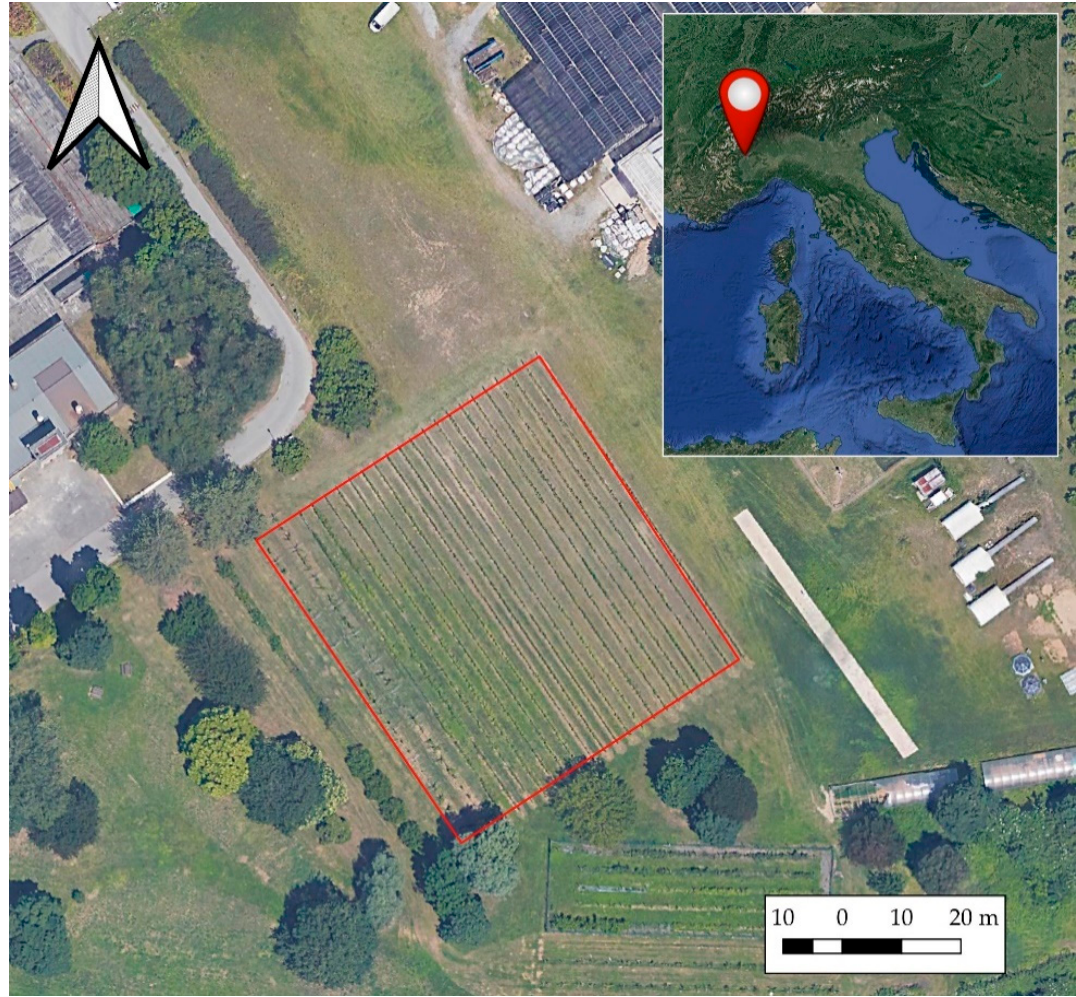
Figure 1. Case study area: the vineyard in Grugliasco University (Piedmont Region, Italy), contoured by red line.